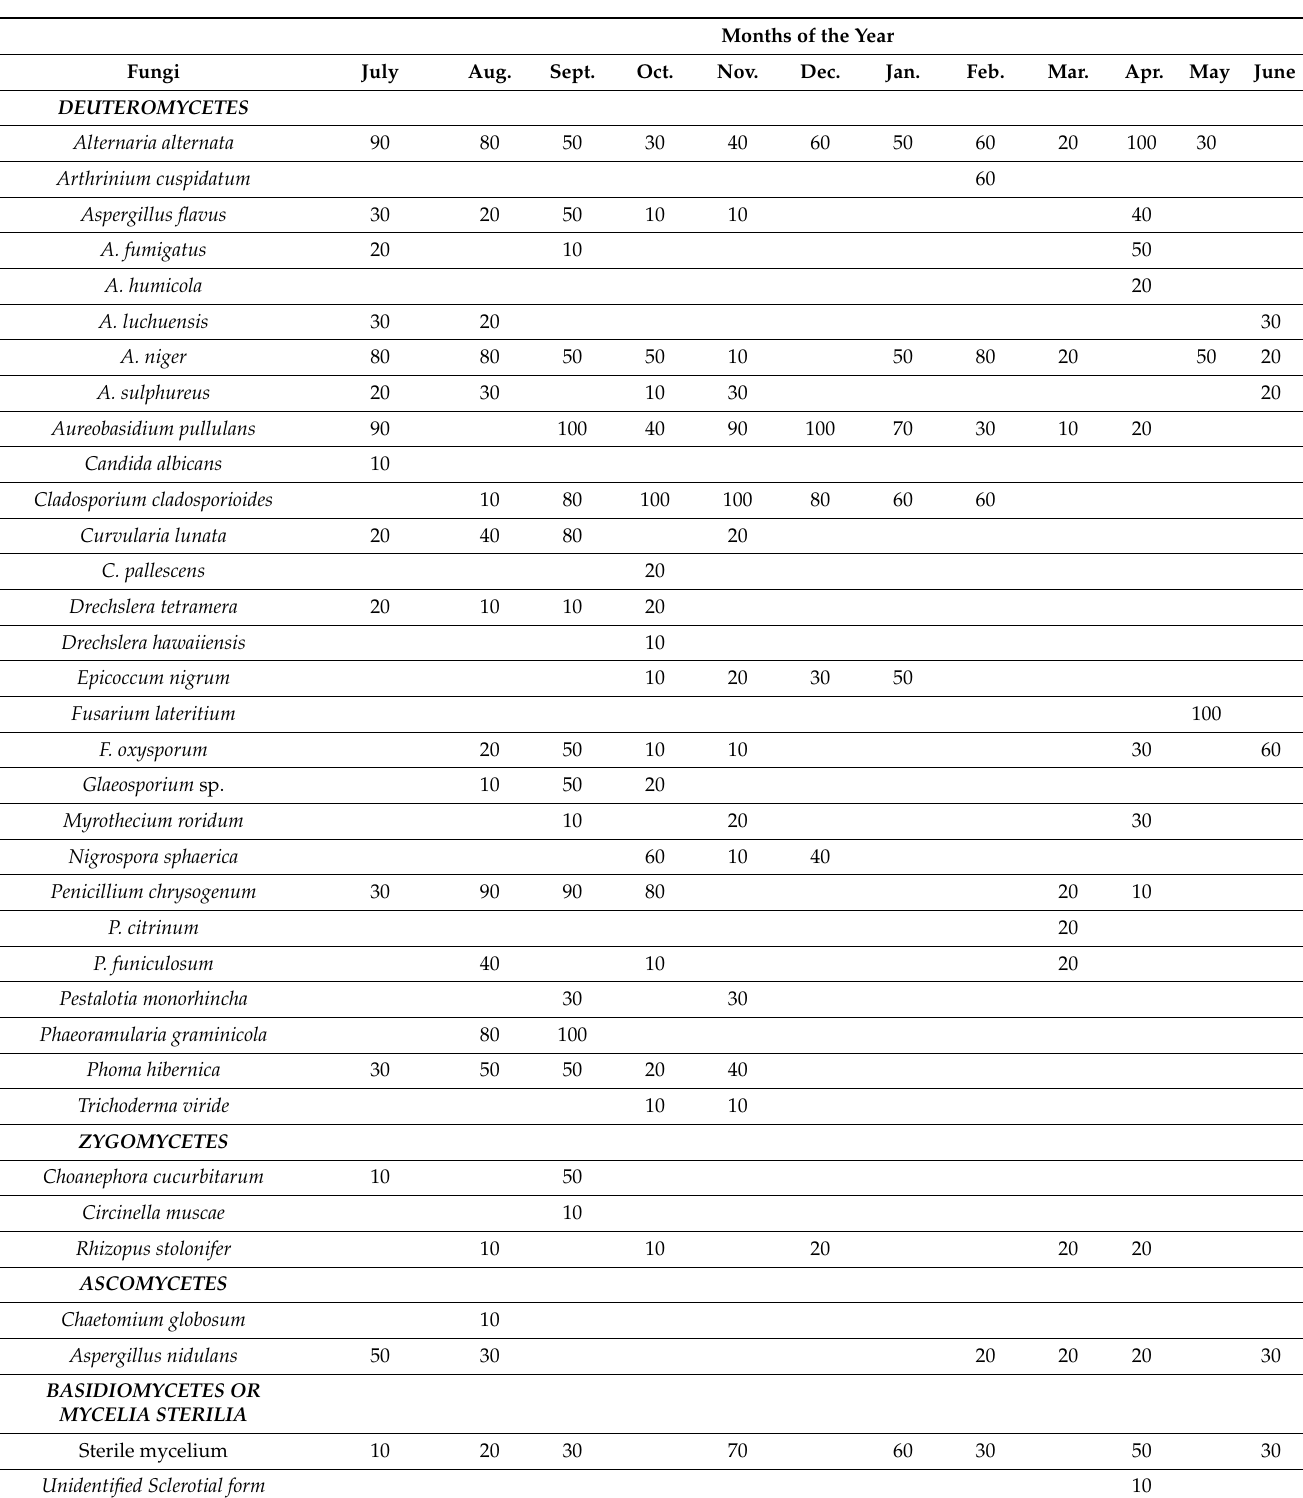
Table 1. Percentage frequency of occurrence of various fungi on Green Attached Leaves (GA) of Leucaena leucocephala